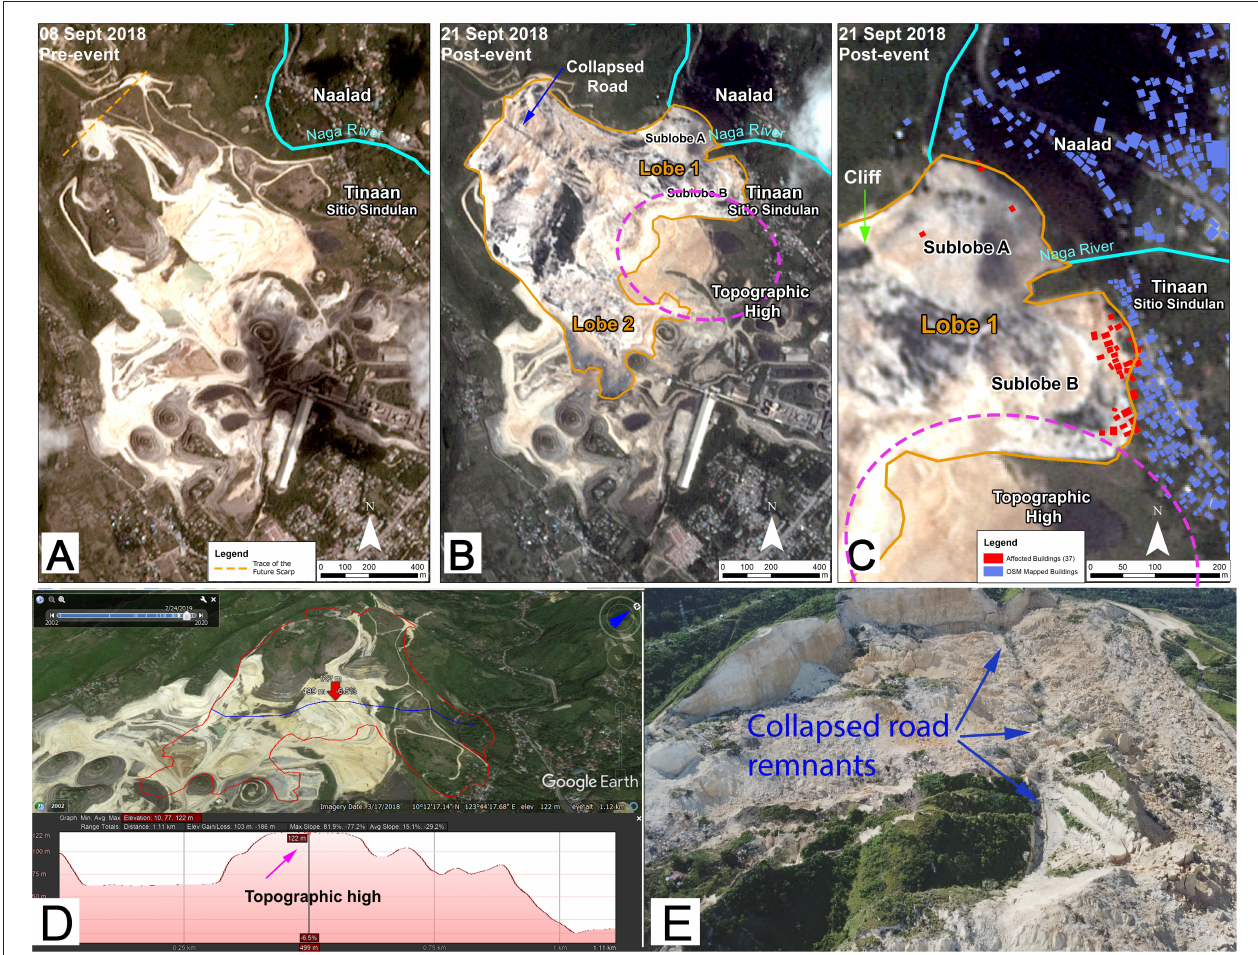
FIGURE 3 | Planetscope satellite images of the Naga landslide area (A) before and (B) after the Naga disaster (C) close up of the Lobe 1 with building footprints ( OpenStreetMap contributors, 2017). There were 37 houses buried in Sublobes A and B. (D) Pre-event cross-section from Google Earth show the “topographic high” that disrupted/diverged the flow of the materials which caused the formation of Lobe 1 and Lobe 2. A natural cliff also caused the formation of Sublobe A and B. Another notable feature of the event is the (E) remnants of the road that collapsed and formed a seemingly linear